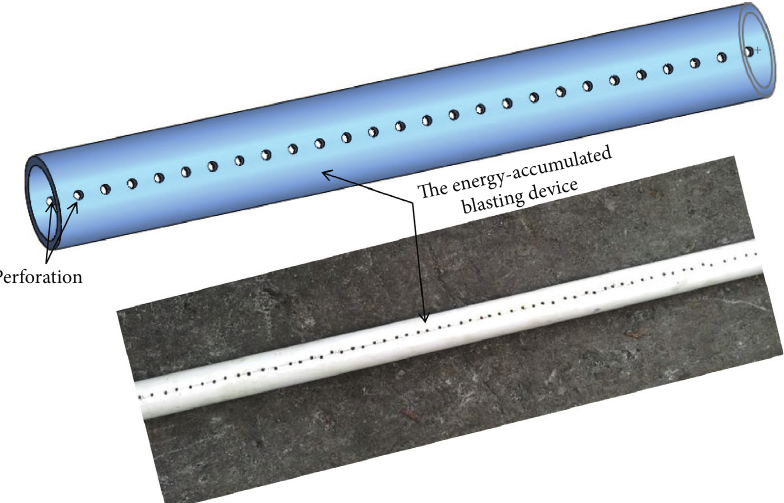
Figure 16: The energy-accumulated blasting device.